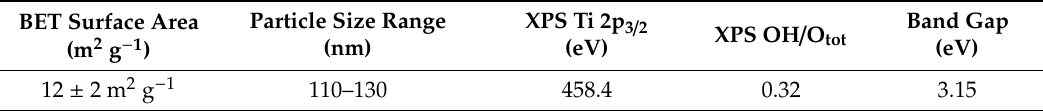
Table 1. Main properties of TiO 2 (1077, KRONOS Worldwide, Inc., USA). BET Surface